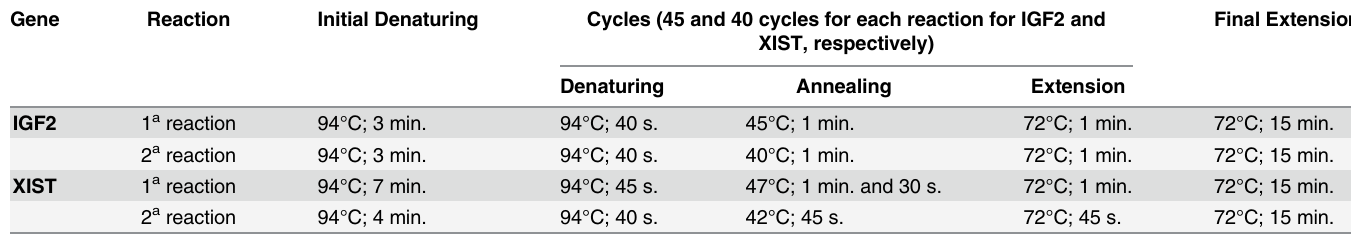
Table 2. Nested PCR conditions for the IGF2 and XIST genes. Gene Initial Denaturing Cycles (45 and 40 cycles for each reaction for IGF2 and